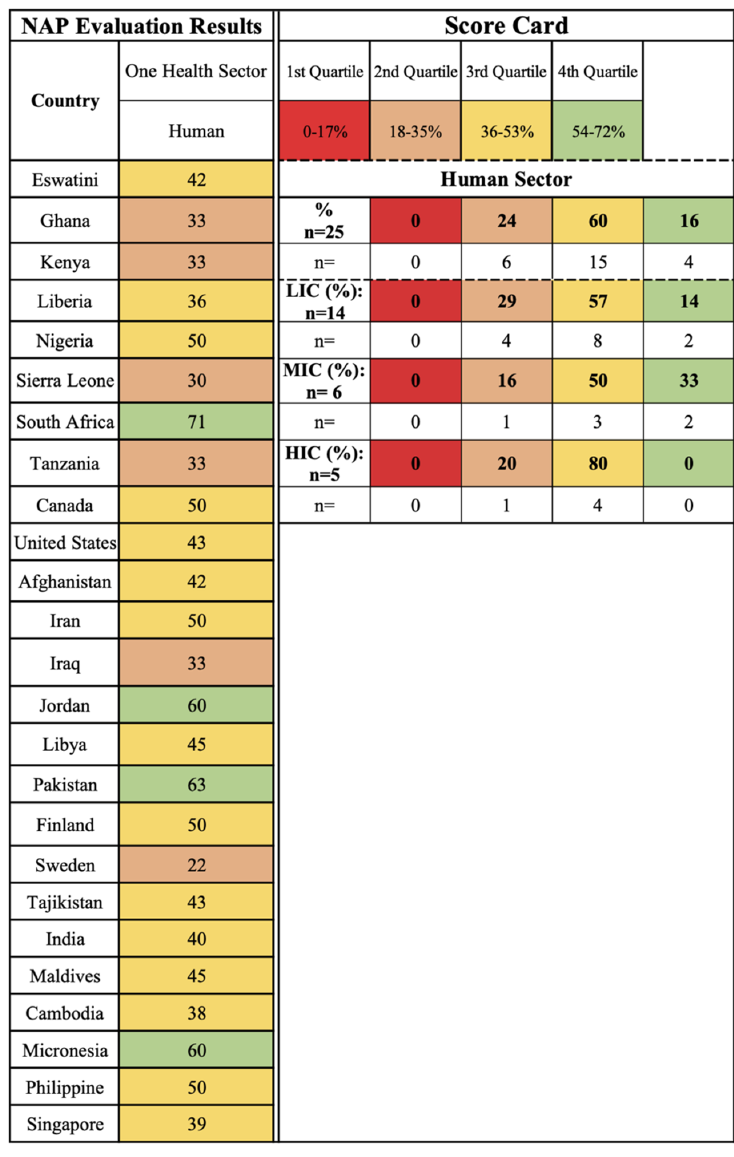
Figure 2. Human One Health sector scorecard by country and income level.